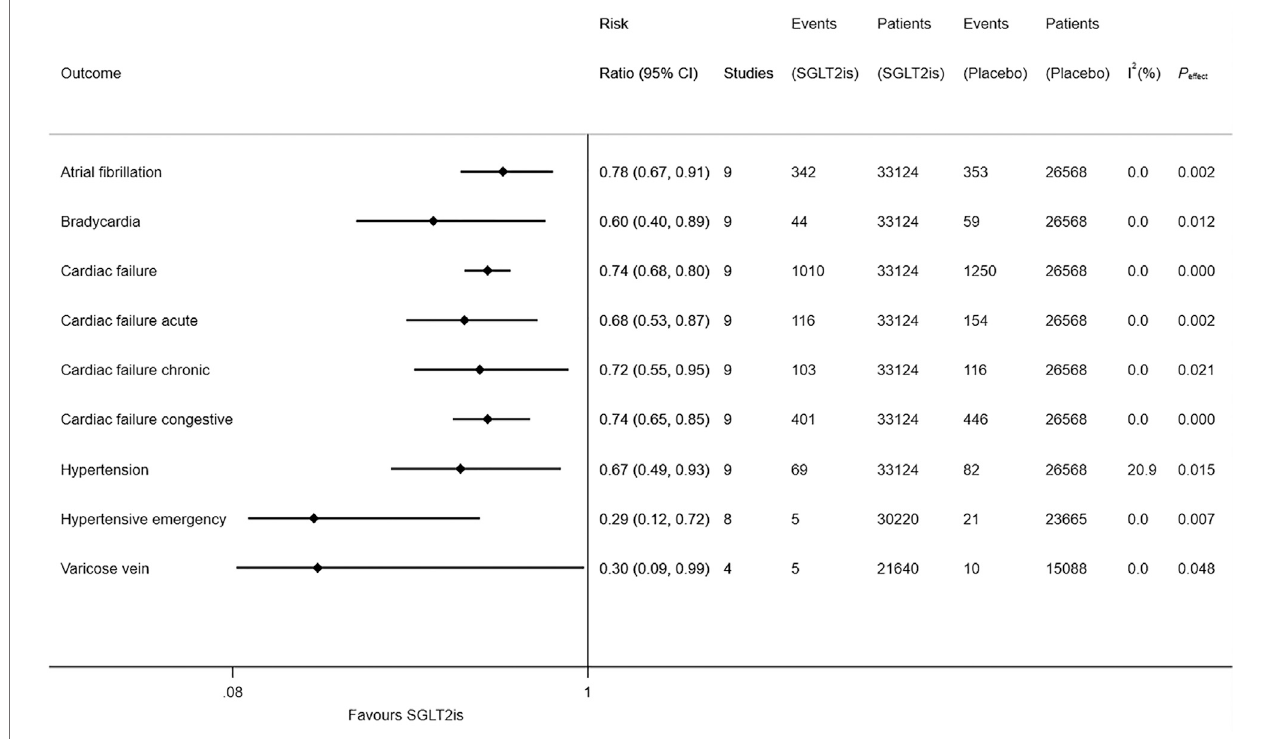
Frontiers in Pharmacology |